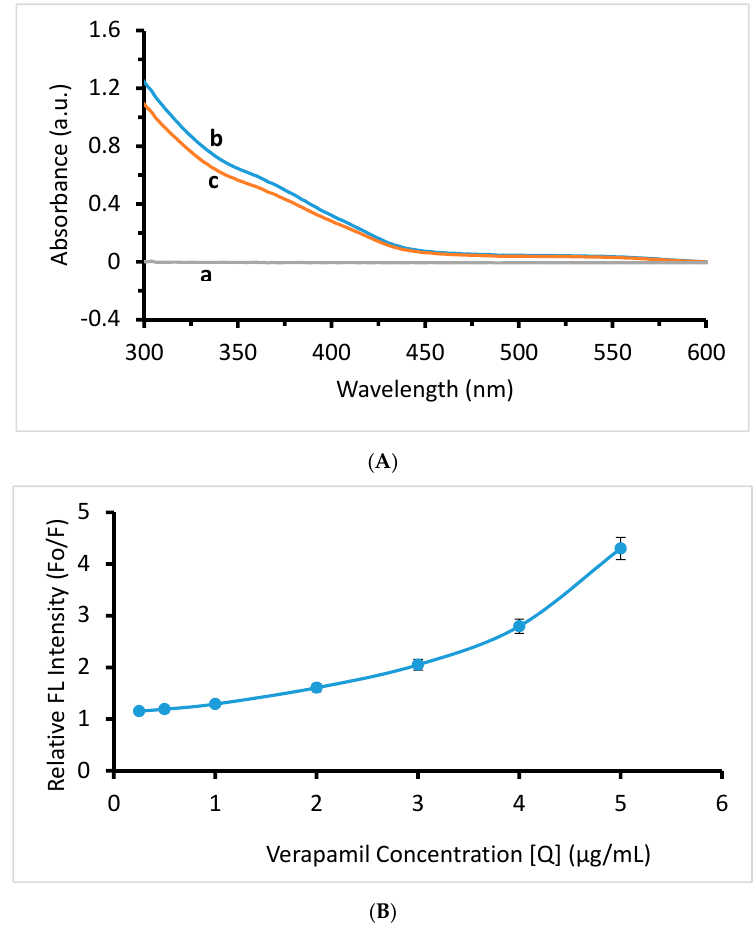
Figure 6. ( A ) Absorbance spectra of verapamil HCl (a), CdTe/CdS/ZnS QDs before (b) and after (c) the addition of verapamil HCl. ( B ) Stern–Volmer plot for different concentrations of verapamil HCl.